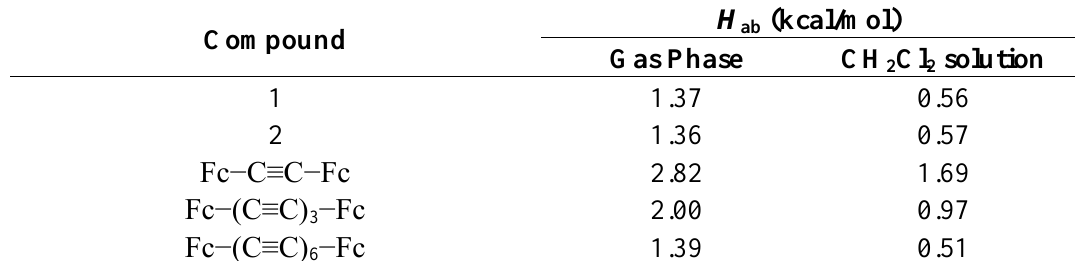
Table 3. Calculated electronic couplings for model